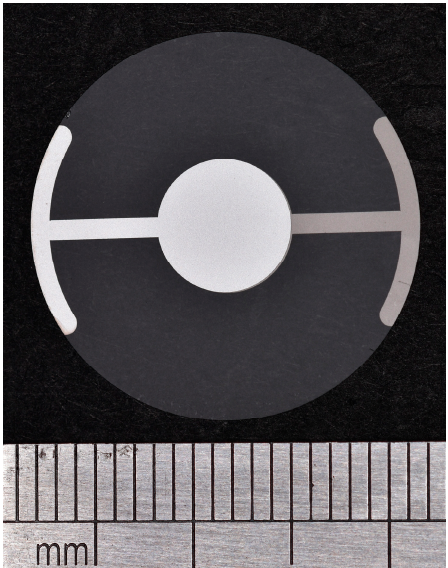
Figure 2. Photograph of a commercially available Quartz Crystal Microbalance sensor with silver electrodes. Scale in millimeters is in the bottom of the photograph.